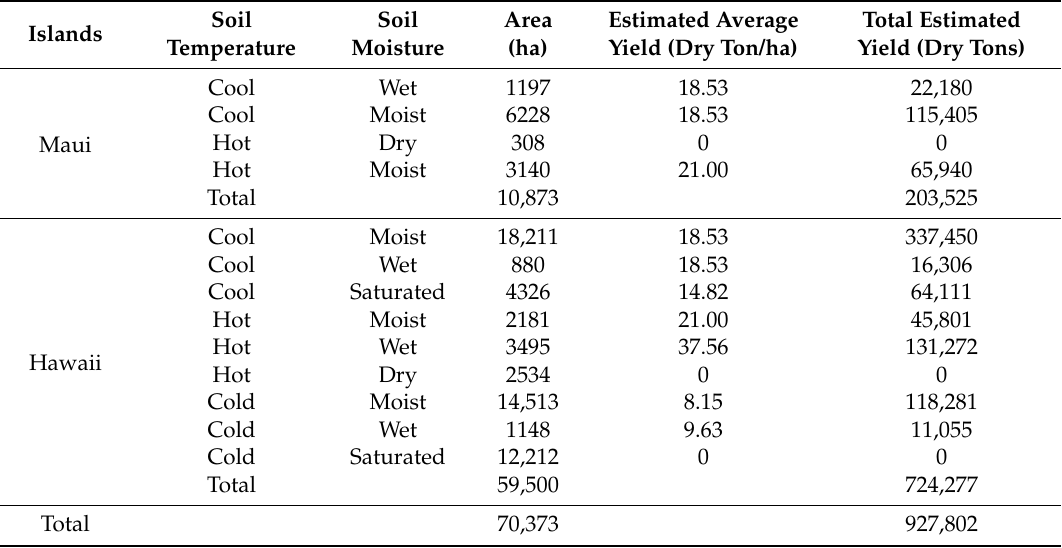
Table 3. Estimated potential banagrass